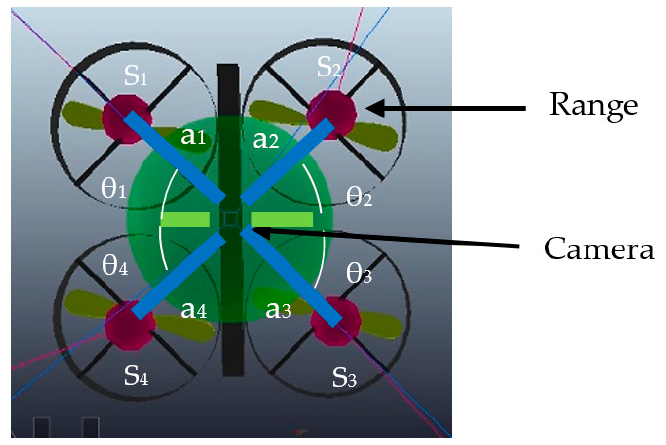
Figure 7. Range sensor positions and angles w.r.t the Figure 7 . Range sensor positions and angles w.r.t the camera.